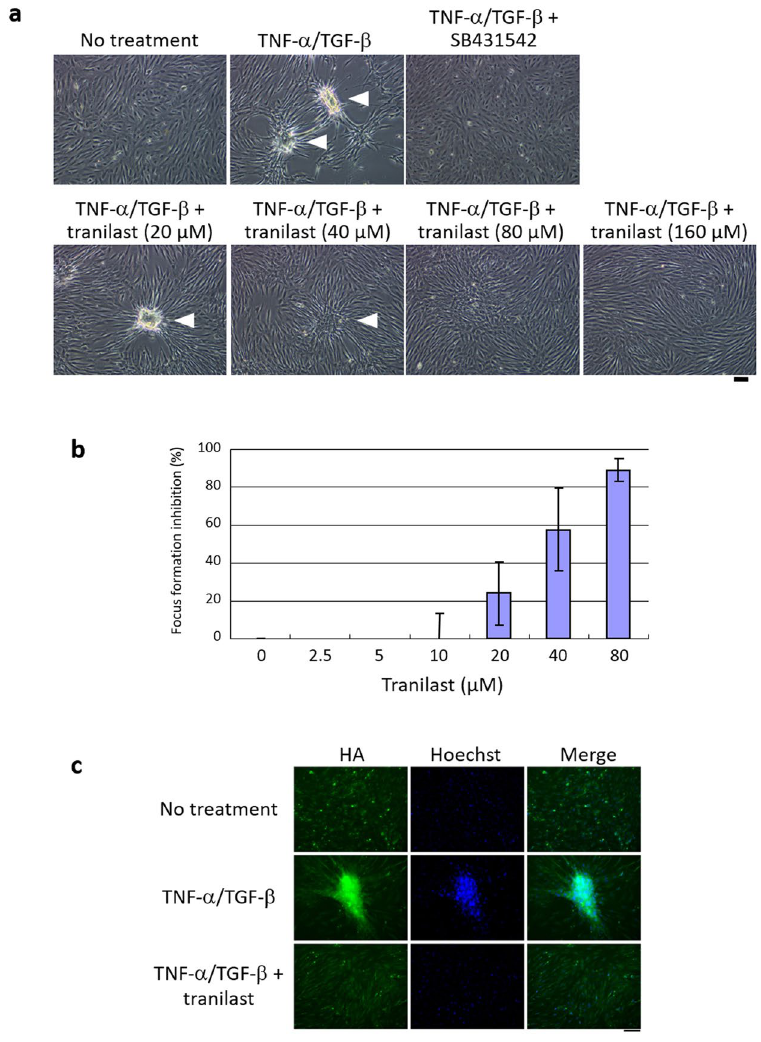
Figure 1. Tranilast inhibits EMT induced by TNF- α and TGF- β 2 in ARPE-19 cells. ( a ) Phase-contrast microscopy of ARPE-19 cells that had been cultured for 5 days to 100% confluence and then incubated for 2 days in the absence or presence of TNF- α (100 ng/ml) and TGF- β 2 (5 ng/ml) as well as of SB431542 (10 µ M) or tranilast (20, 40, 80, or 160 µ M). Arrowheads indicate cell aggregation. Scale bar, 100 µ m. ( b ) Concentration- dependent inhibition by tranilast of ARPE-19 focus formation induced by TNF- α and TGF- β 2 was assayed as in a. Data are means ± s.d. from three independent experiments. ( c ) ARPE-19 cells incubated in the absence or presence of TNF- α /TGF- β 2 and tranilast (160 µ M) for 2 days were stained with biotinylated HABP (and Alexa Fluor 488–conjugated streptavidin) for detection of HA as well as with Hoechst 33342 for detection of nuclei. The cells were then observed by fluorescence microscopy. Scale bar, 100 µ